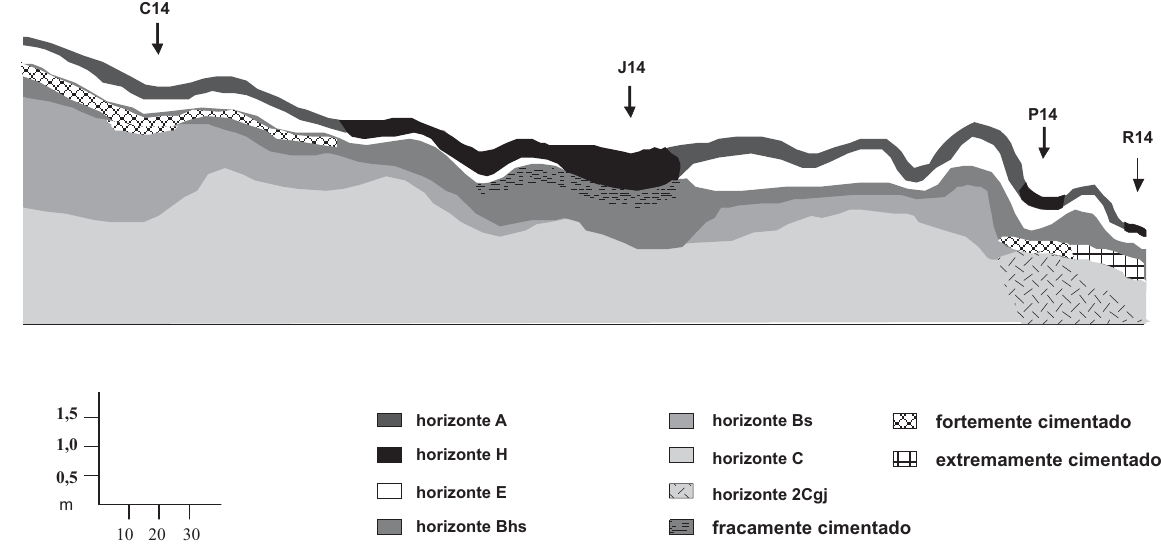
horizonte Bs fortemente cimentado horizonte C extremamente horizonte 2Cgj fracamente cimentado